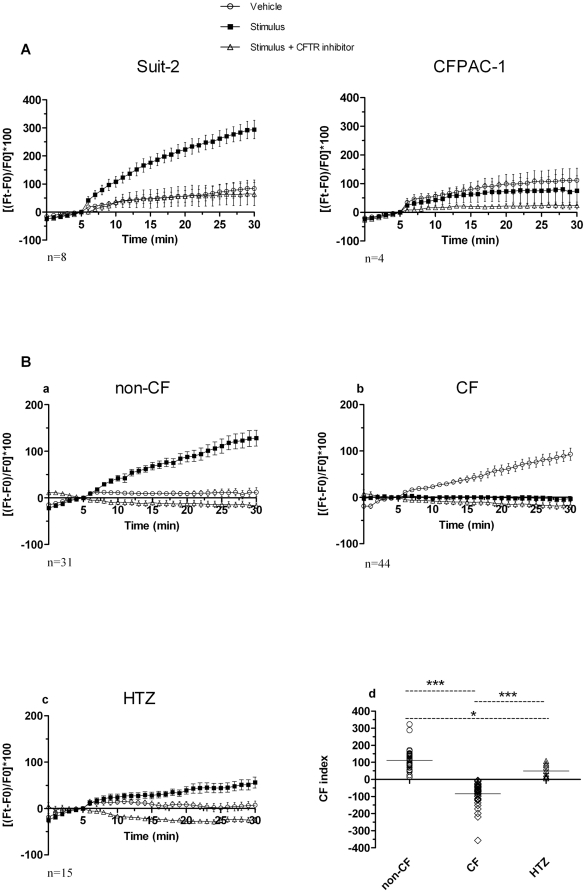
Fluorescence-based CFTR functional analysis.Percentage of DiSBAC2(3) fluorescence variation (ΔF) is shown over time of addition of the stimulus 8-Br-cAMP/forskolin/IBMX, according to the equation: ΔFt = [(Ft-F0)/F0]×100, where Ft and F0 are the fluorescence values in absence of extracellular chloride at time t and at the time of addition of the stimulus respectively. Graphs show mean ΔFt and standard error. CFTR (inh)-172 (CFTR inhibitor) was added where indicated. Panel A: Suit-2 and CFPAC-1 pancreatic adenocarcinoma cell lines used as positive and negative controls, respectively, at the recording times indicated on the x axis. Panel B: Same as panel A using purified human monocytes of non-CF (a), CF (b) and HTZ (c) donors. (d) Differences between the maximum fluorescence value obtained under stimulation and the matching fluorescence value of vehicle (CF-index). CF group showed values of CF-index significantly lower (median: −70.2, IQR: −113.7;−47.5) both than the HTZ group (median: 50.5; IQR: 17.8, 84.7) and the non-CF group (median: 113.3, IQR: 57.3, 147.3), both p<0.001 (***); also the difference found between the non-CF and HTZ groups was statistically significant (p = 0.015, *).